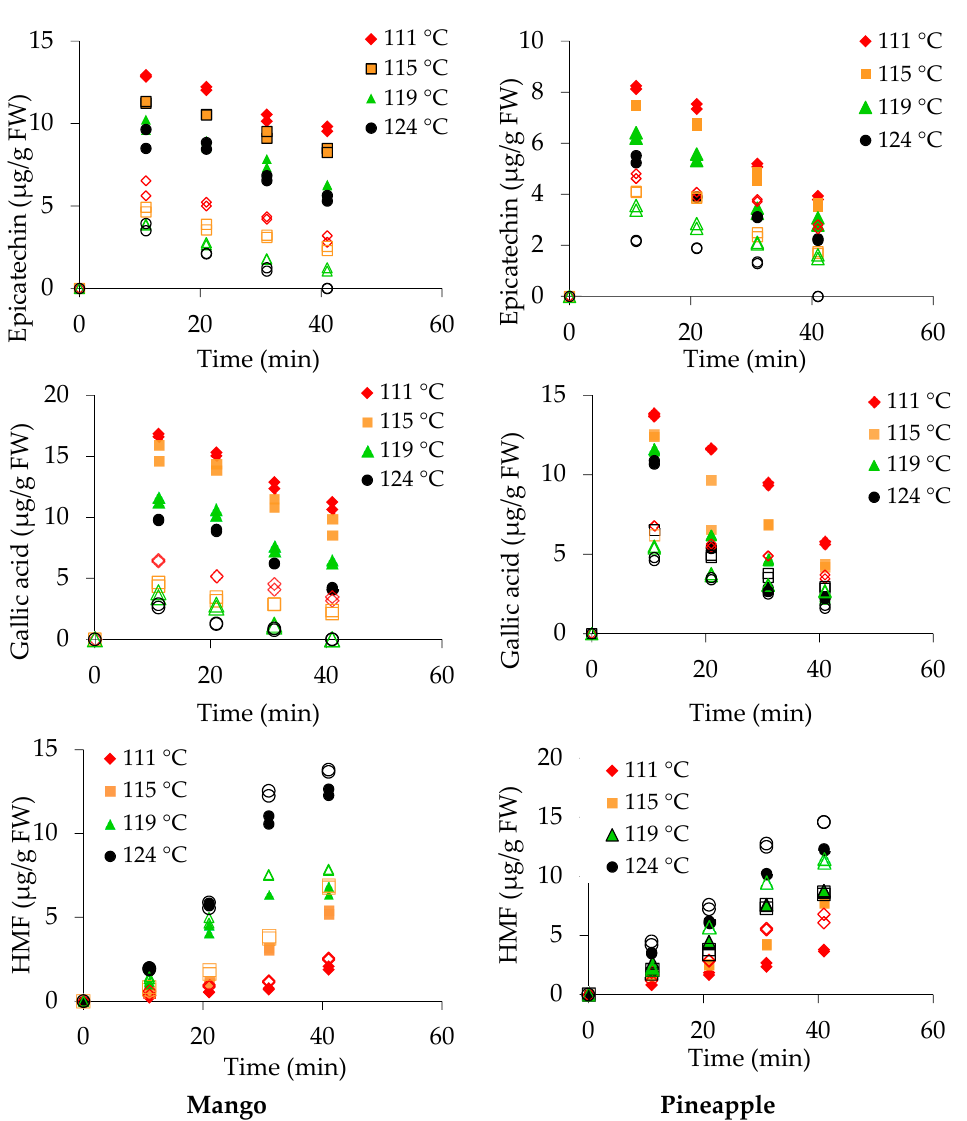
Figure 3. Epicatechin, gallic acid, and Hydroxymethylfurfural (HMF) concentrations in mango and pineapple pieces (closed symbols) and syrup (open symbols) during canningat different temperatures.